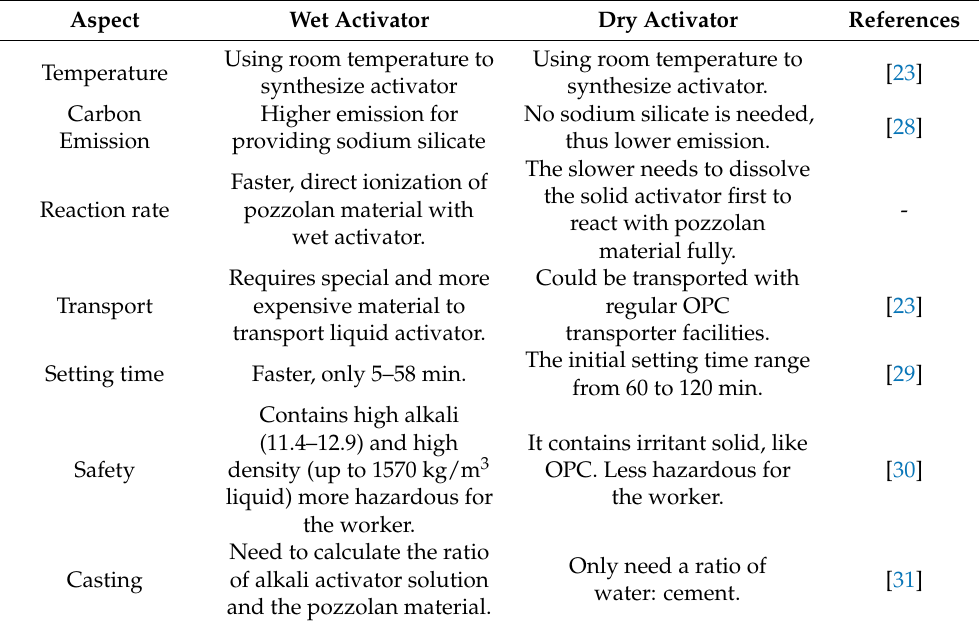
Table 1. Comparison of wet versus dry activator in geopolymer